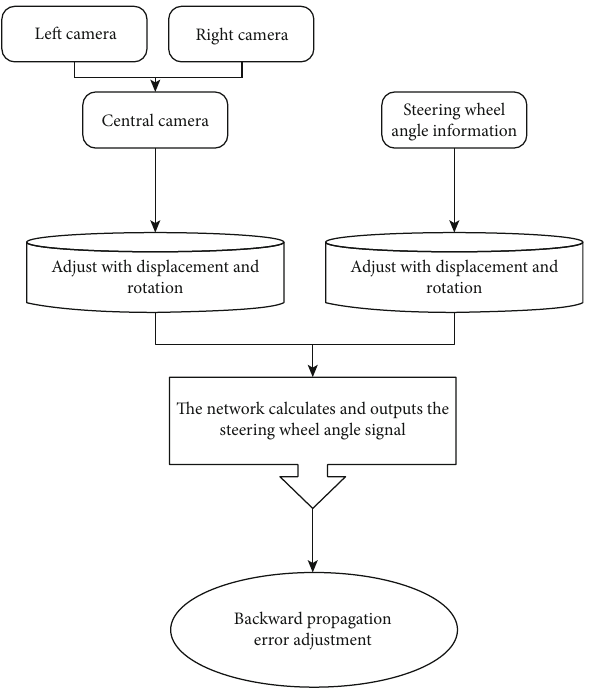
Figure 2: 3D target perception